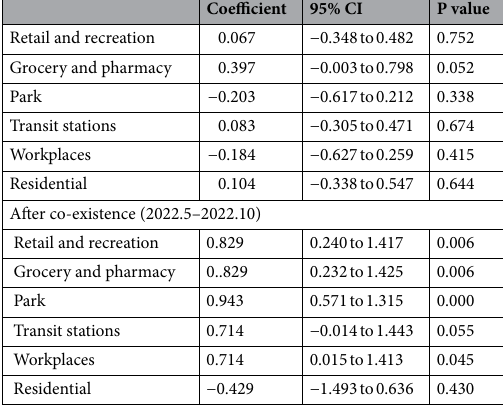
Table 3. Relationship of changes in population mobility at various locations with the monthly operating income of 7-Eleven stores.